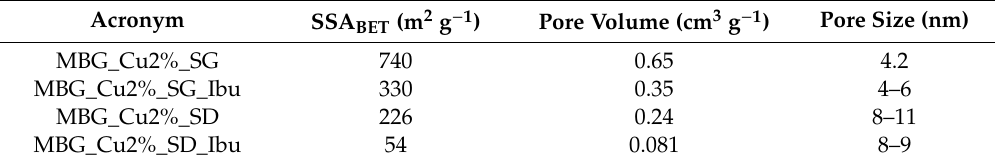
Table 2. Structural properties (i.e., specific surface area -SSA BET -, pore volume, pore size)